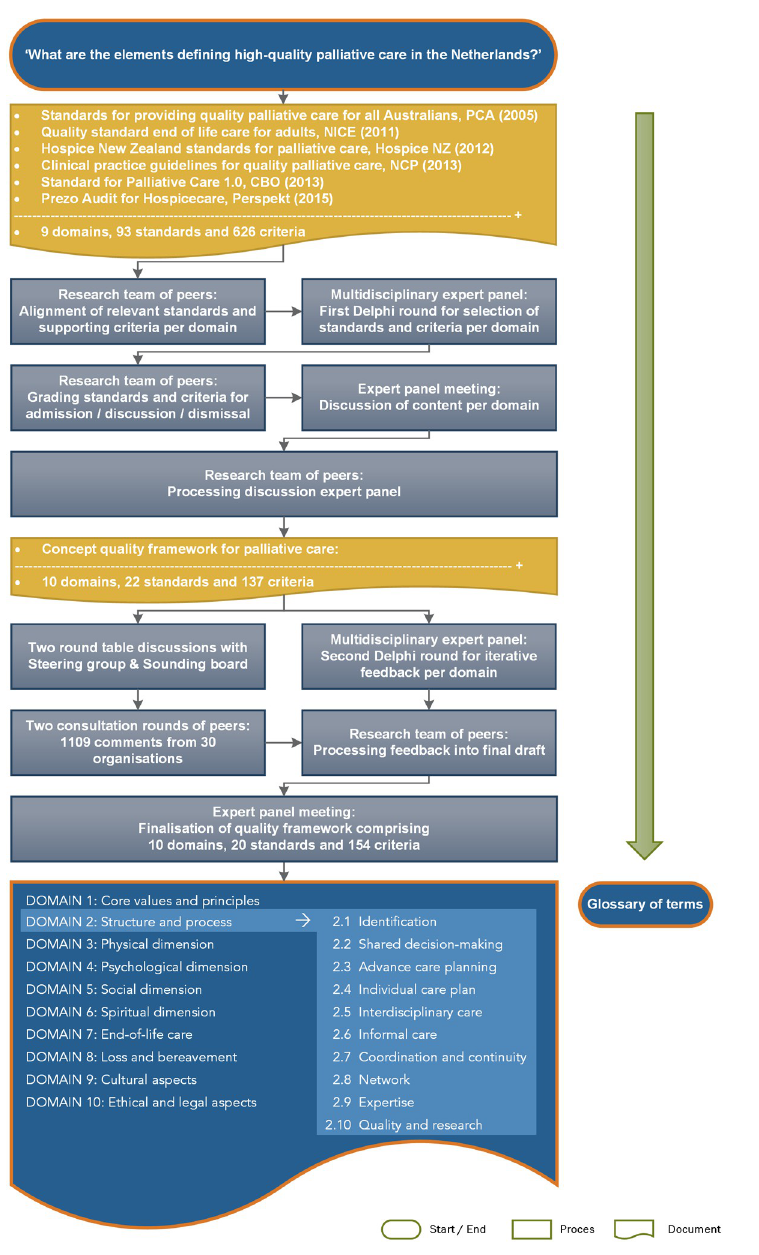
Fig 4. Developing the content of the quality framework including a glossary of